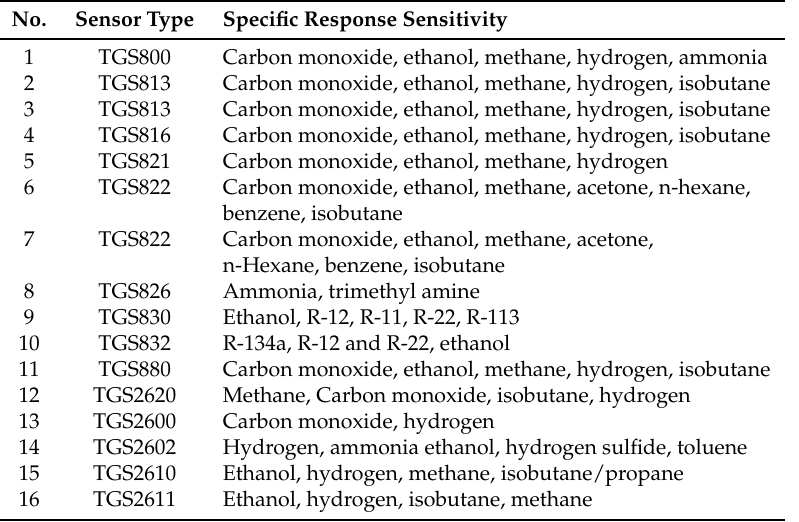
Table 1. The response characteristics of